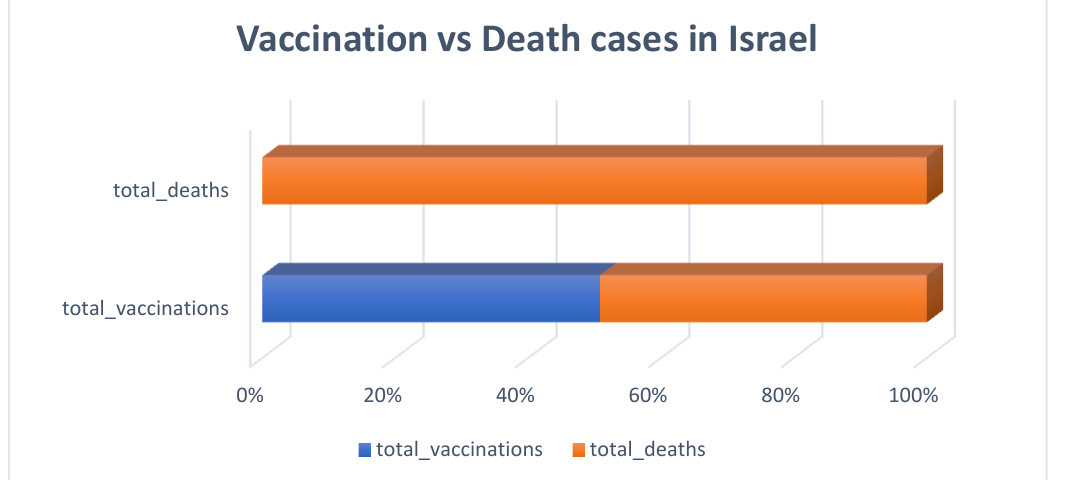
Figure 5. COVID-19 mortality cases in Israel.